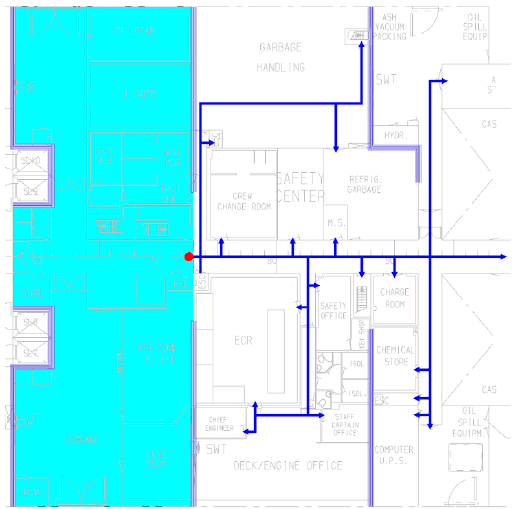
Figure 16. A schematic of floodwater pathways in a complex cruise ship environment.